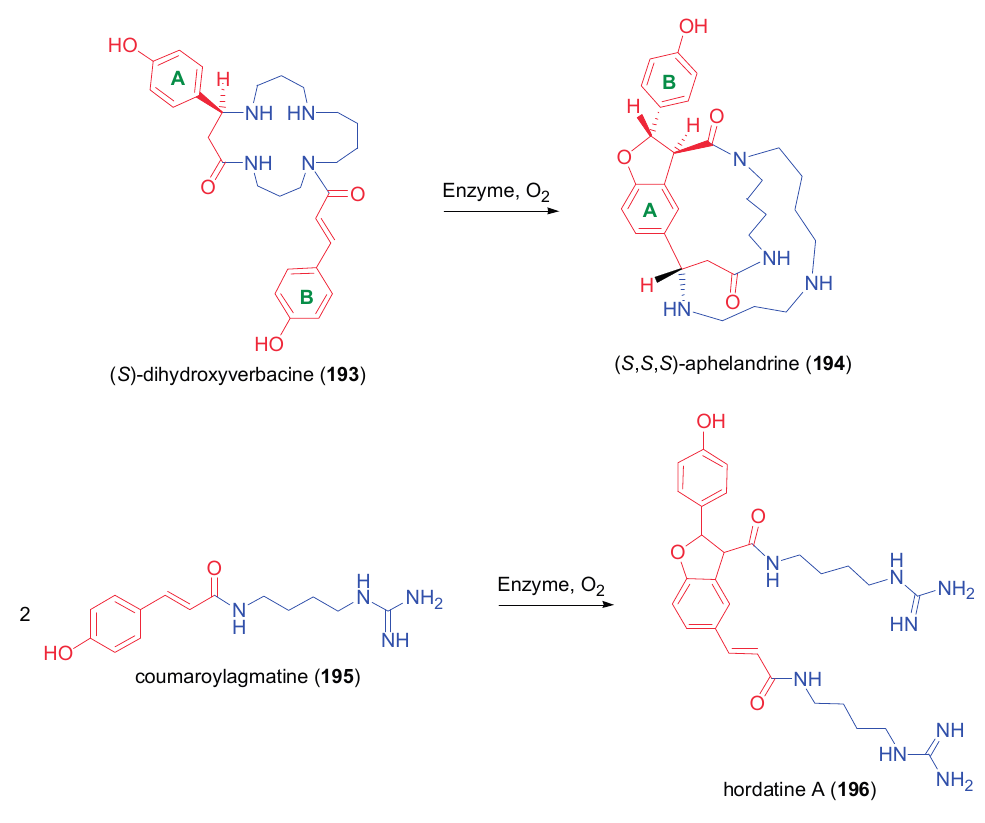
Figure 10. The structure of (+)-LitA ( 197 ) and outline of plausible mechanism for the formation of core dihydrobenzofuranoid structure by either POC of CafA or cross-POC of CafA with